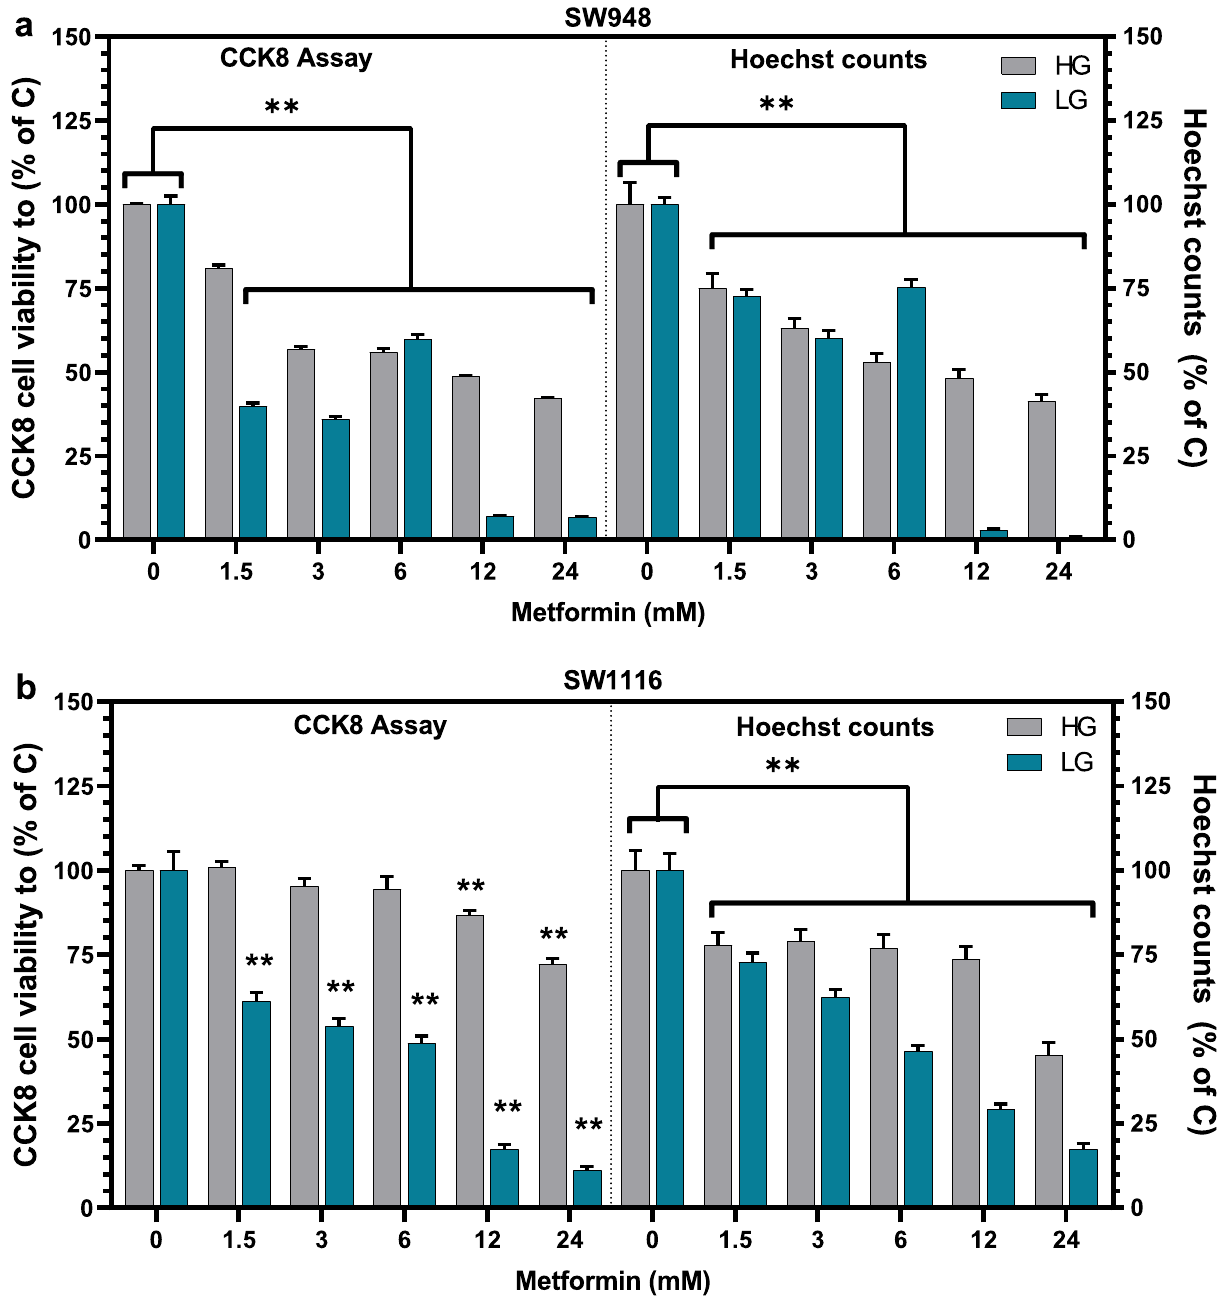
Figure 2. Viability assays of SW948 and SW1116 after metformin treatment for 48 h. The effect on the viability of ( a ) SW948 cells and ( b ) SW1116 in HG (25 mmol/L) and LG (5 mmol/L) is presented. Viability was calculated using CCK-8 (left) and cell counts were scored using fluorescent microscopy on Hoechst stained cells (right). CCK-8 absorbance values and the calculated cell numbers for all metformin treatments (1.5–24 mM) were compared to high glucose control (25 mmol/L, 0 mM Metformin) to show relative viability and cell numbers. Error bars denotes s.e.m, and statistical analysis was calculated using two-way ANOVA (** is p < 0.05) in GraphPad Prism (N = 3). C Control, HG high glucose, LG low